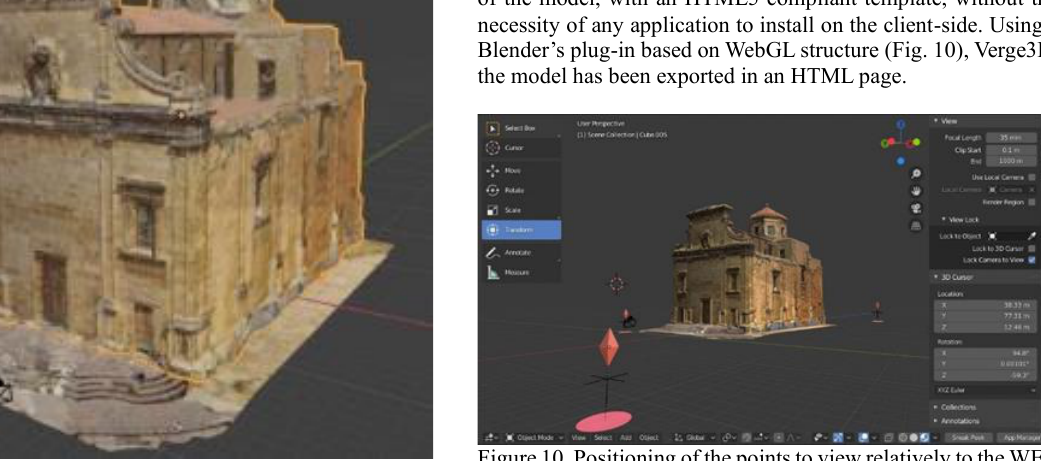
Figure 8. The textured mesh model of the church obtained following the second solution after editing operations in Blender.